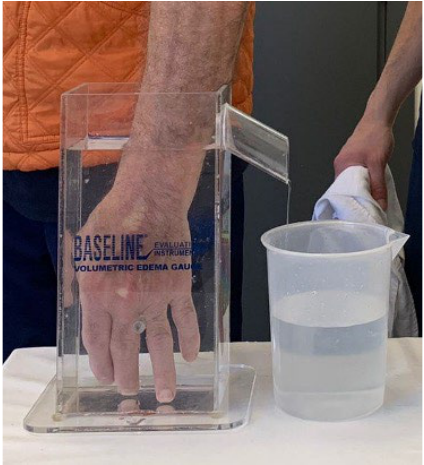
Figure 1. Illustration of hand edema measurement through a hand volumeter. The third interdigital space is placed straddling the dowel of the volumeter. The displaced water is measured by a graduated cylinder.